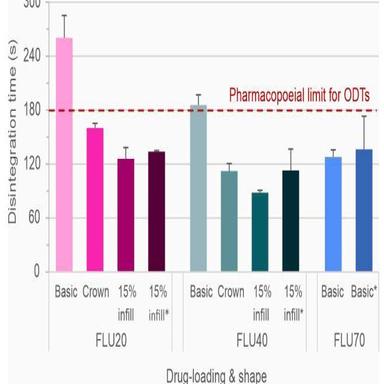
The disintegration time of the printed tablets determined in the pharmacopoeial apparatus ( - tablets made of aged filaments).